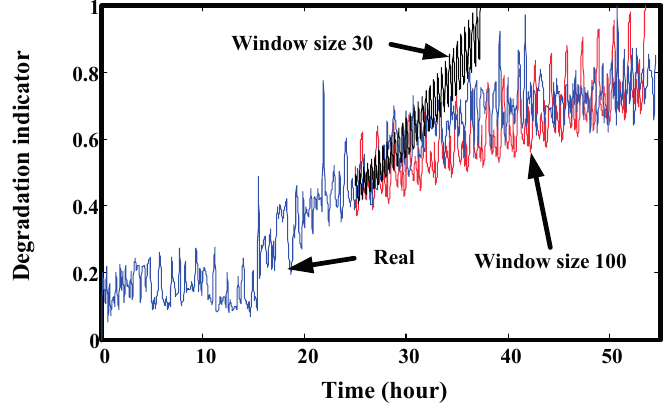
Figure 8. Prediction results comparison using different window sizes (start at 25